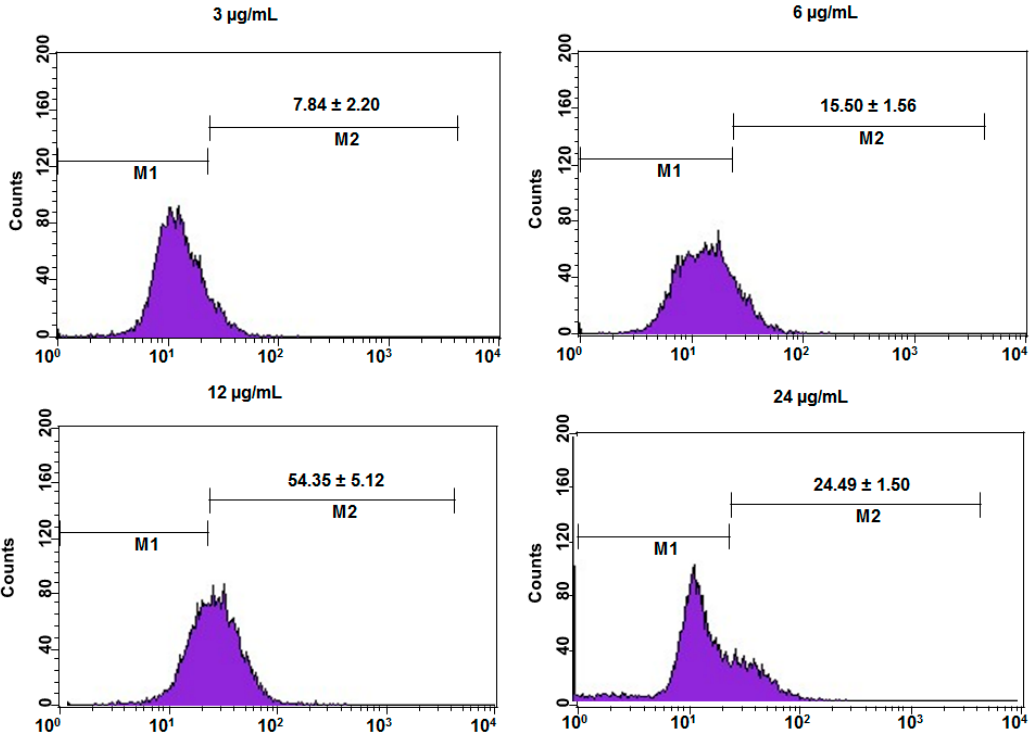
Figure 11. The concentrations (3, 6, 12 and 24 µg/mL) of DEN-HP β CD complex in HT29-treated cells induced ROS generation. Results are represented one of the three independent experiments. Note: M1 represented the cells that not producing ROS, M2 represented the cells that actively producing ROS.